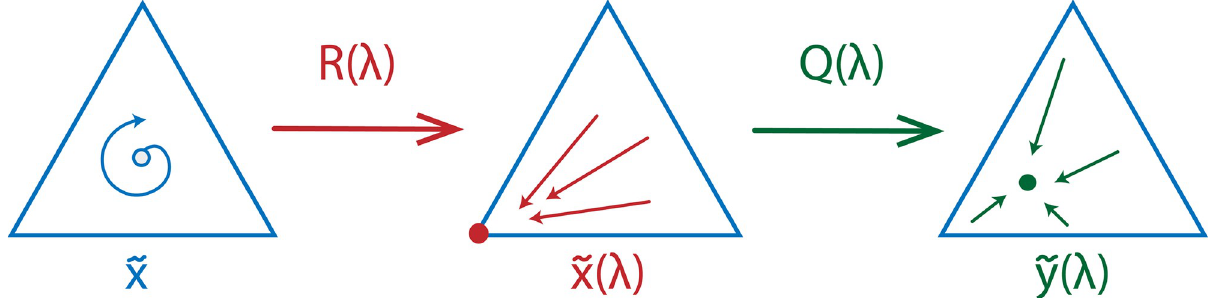
Fig 5. A schematic representation of a possible influence of execution errors on the RPS dynamics. The original game possesses an unstable equilibrium ~ x . Once the execution errors are introduced, for some λ the game can obtain a stable equilibrium ~ x ð l Þ represented by a vertex i . As the probability to play mixed strategies in this case is high, it keeps disturbing the strategy execution of the players choosing strategy i according to Eq (7) resulting in an equilibrium ~ y ð l Þ that is possibly in the